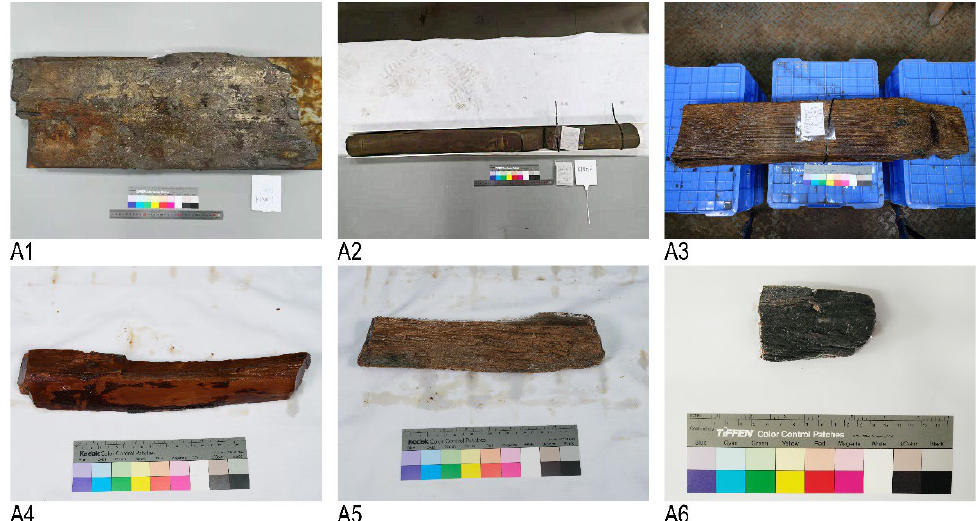
Figure 1. Images of the original states of the waterlogged archaeological wood samples. (A1–A5 were collected from Nanhai No. 1; A6 was collected from Changjiangkou No. 2). Table 1. The sample information. Samples Wood Species Origin